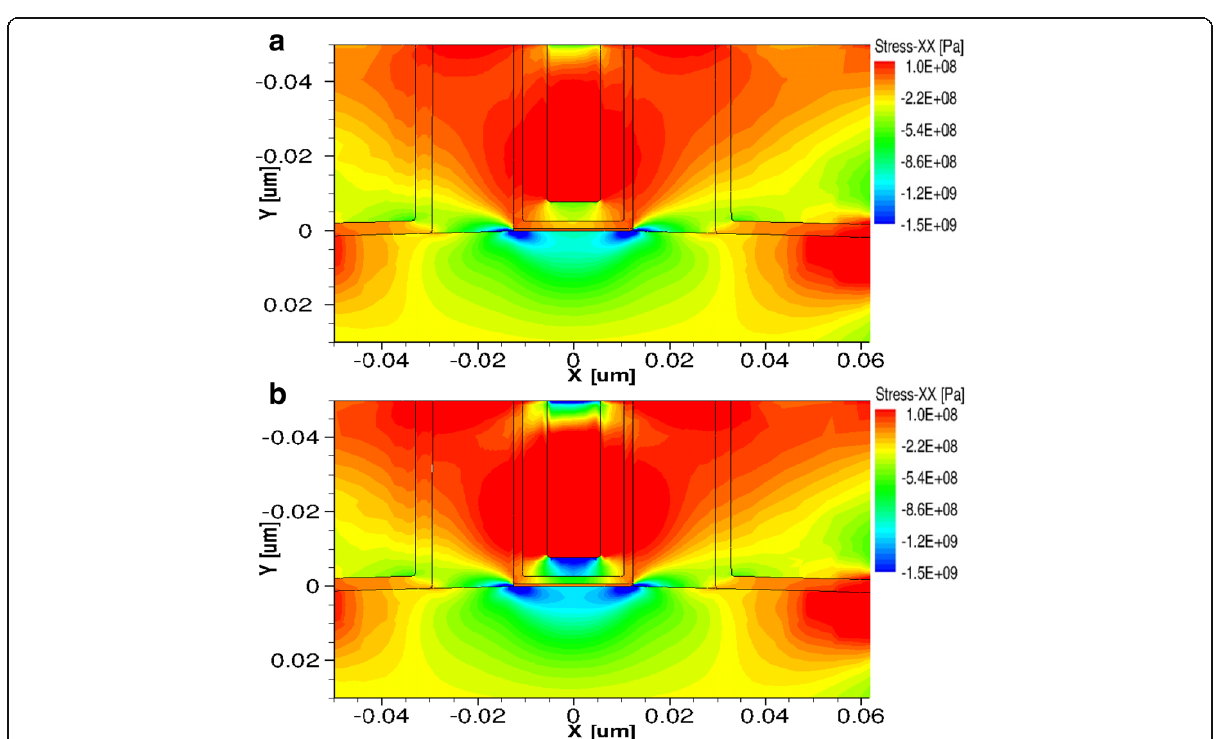
Fig. 4 The TCAD simulation of strain distribution in the channel by a tensile ALD W using B 2 H 6 and b tensile ALD W using SiH 4 filled in the trench